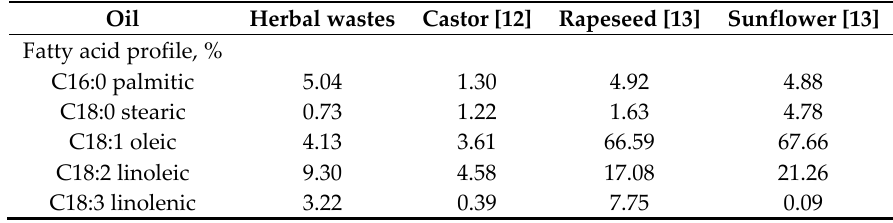
Table 1. Fatty acid profile of herbal wastes and comparison with other biodiesel oils. Oil Herbal